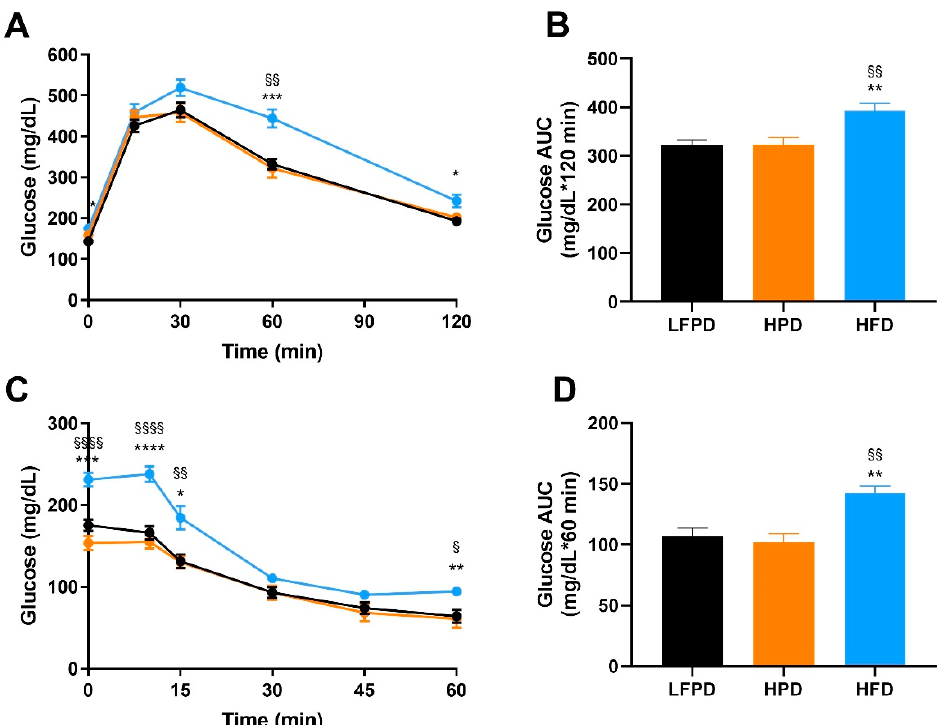
Figure 2. Six weeks of HFD impaired whole-body glucose tolerance and insulin sensitivity. ( A ) Glu- cose tolerance test exclusion curve, ( B ) Glucose tolerance area under the curve (AUC), ( C ) Insulin tolerance test exclusion curve, and ( D ) Insulin tolerance AUC. N = 14–30 per group. One or two-way ANOVA were used with Tukey’s multiple comparison test (* p < 0.05, ** p < 0.01, *** p < 0.001, **** p < 0.0001 LFPD vs. HFD, § p < 0.05, §§ p < 0.01, §§§§ p < 0.0001 HPD vs. HFD). Data are expressed as the mean ±